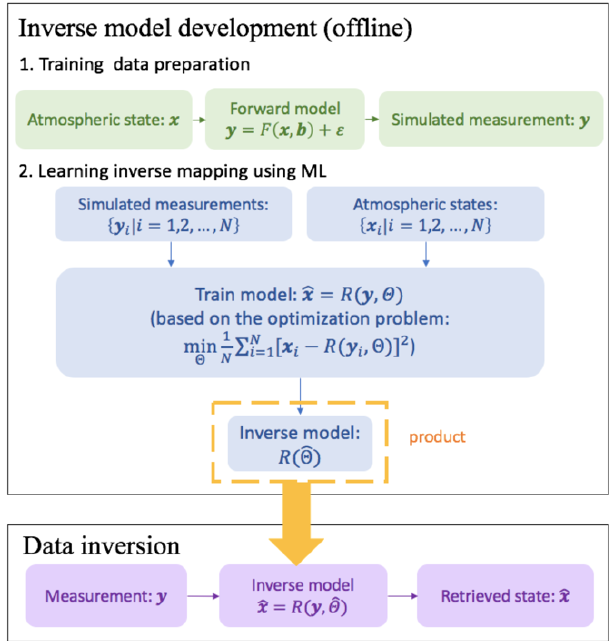
Figure 5. Schematics of the machine learning inversion